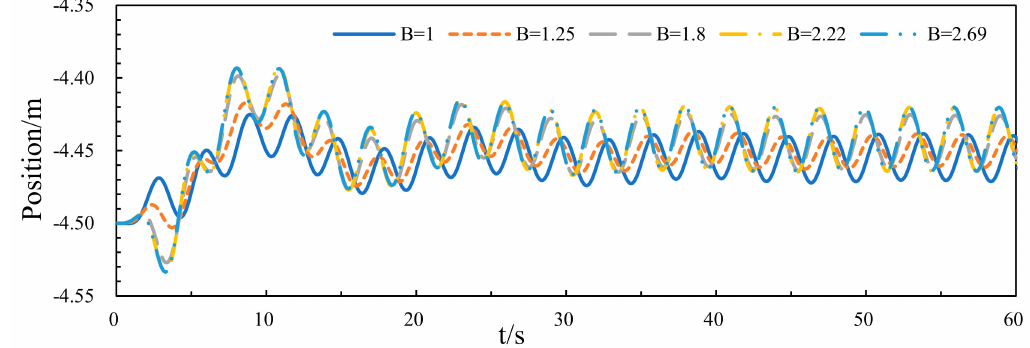
Figure 5. Oscillation curve of the central